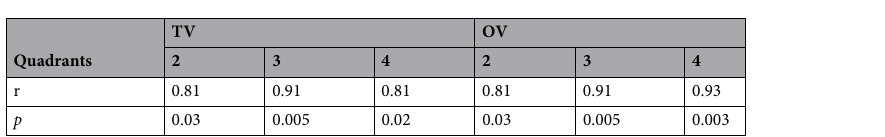
Table 5. Correlation between osteophyte formation and OA severity. TV: Total volume of interest; OV: Osteophyte volume. The correlation coefficient, r, and p values are reported. p < 0.01 was considered significant.